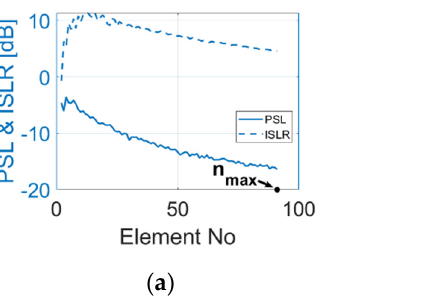
Table 2. PSL and ISLR for each optimised pattern.